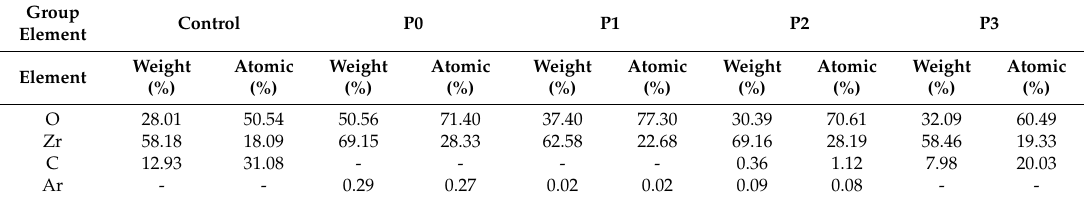
Figure 4. Energy-dispersive X-ray spectroscopy elemental spectrum after plasma treatment. An attempt was made to detect carbon (C), oxygen (O), argon (Ar), and zirconium (Zr). ( a ) Control (no treatment), ( b ) P0 group (immediately after treatment), ( c ) P1 group (24 h after treatment), ( d ) P2 group (48 h after treatment), ( e ) P3 group (72 h after treatment). Table 3. Energy-dispersive X-ray spectroscopy elemental analysis after plasma treatment, according to different time intervals.